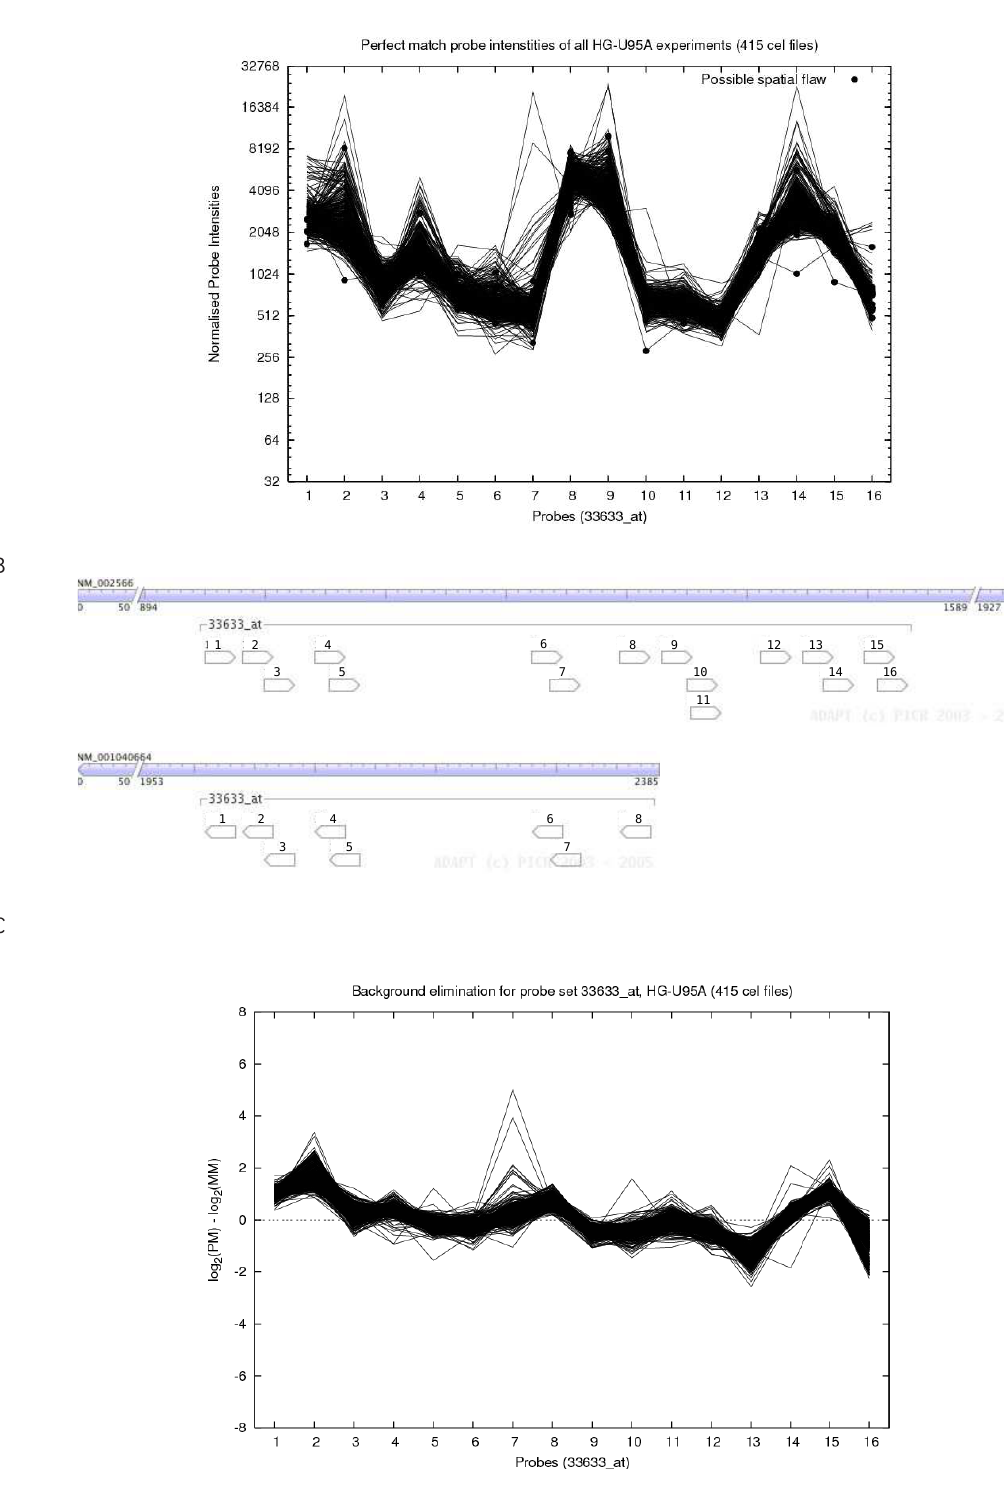
Supplementary Figure 6: Probe intensities over all cel files for probe set 33633 at on the HG U95A array (A) Perfect match intensities (log scale) (B) ADAPT probe positions on the transcripts (C) Background elimination (log 2 (PM) - log 2